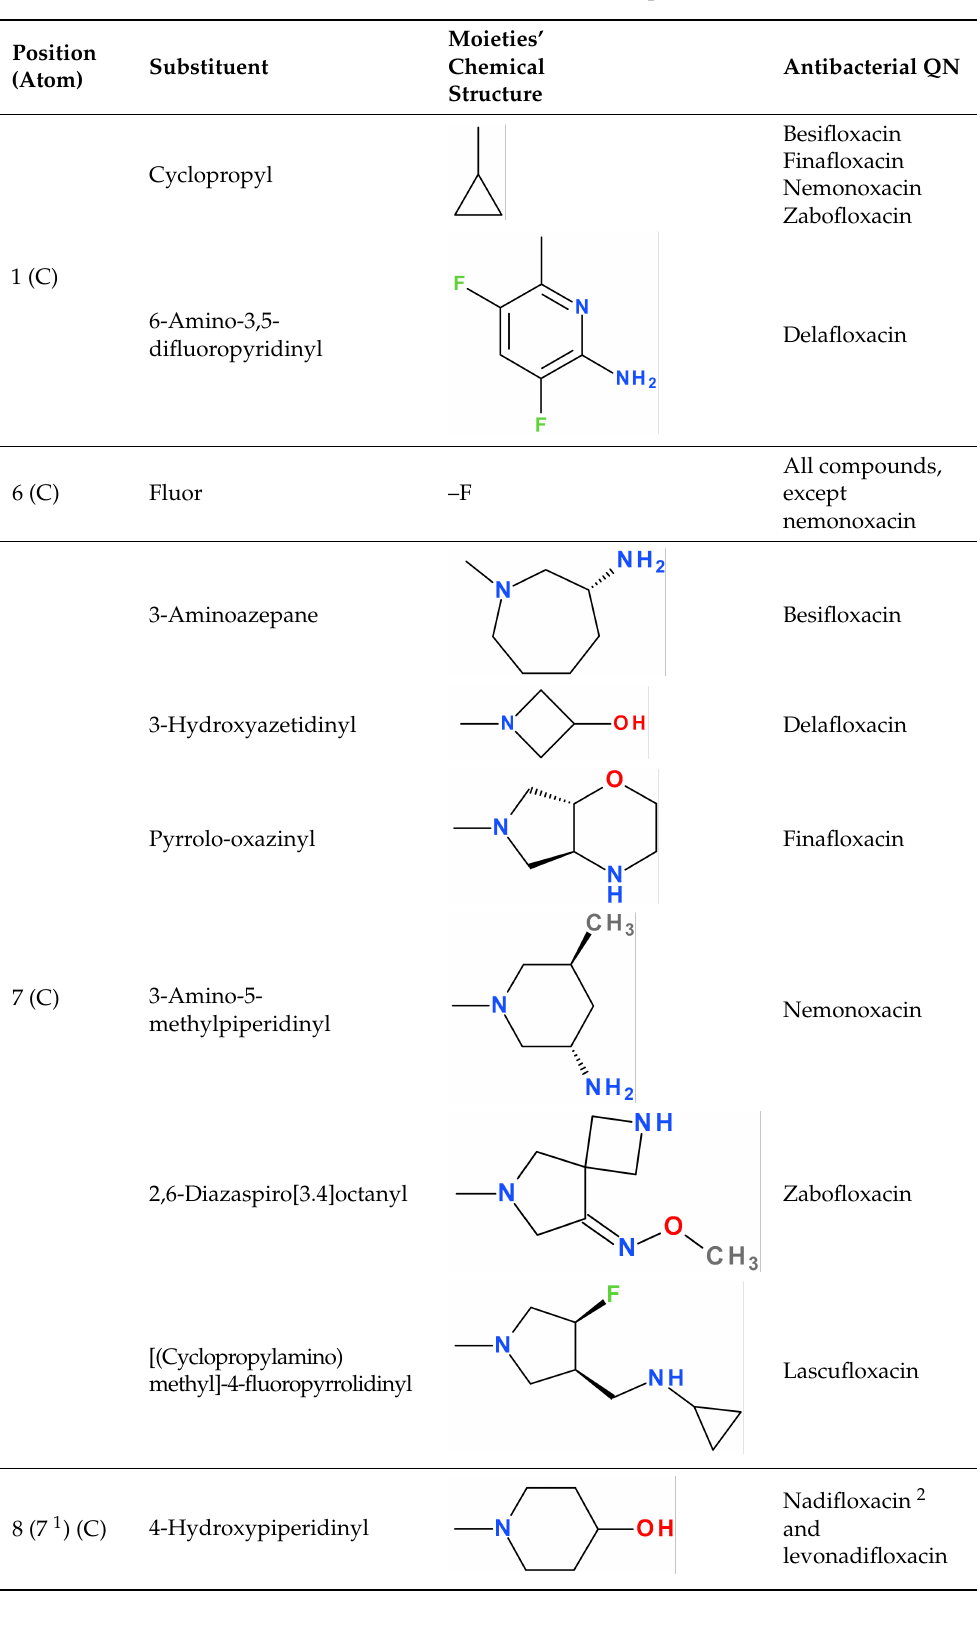
Table 10. Essential moieties on the QN nucleus for the newer